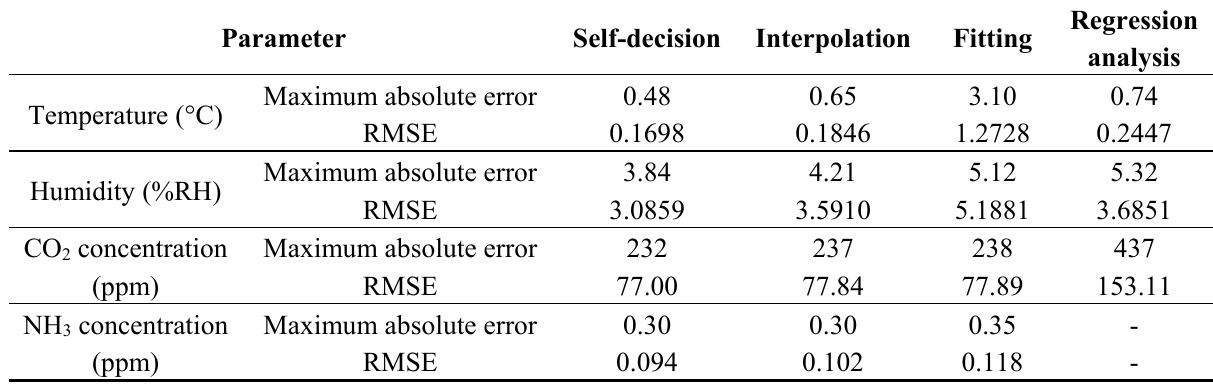
Table 1. Comparison of estimation